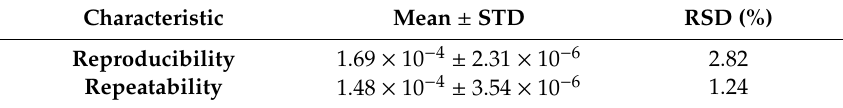
Figure 10. The selectivity of the developed sensor. 3.3.3. Limit of Detection (LOD) The calibration graph and mercury detection limits of the developed mercury sensor were analyzed using the DPV method. DPV is a sensitive technique which allows for the high accuracy